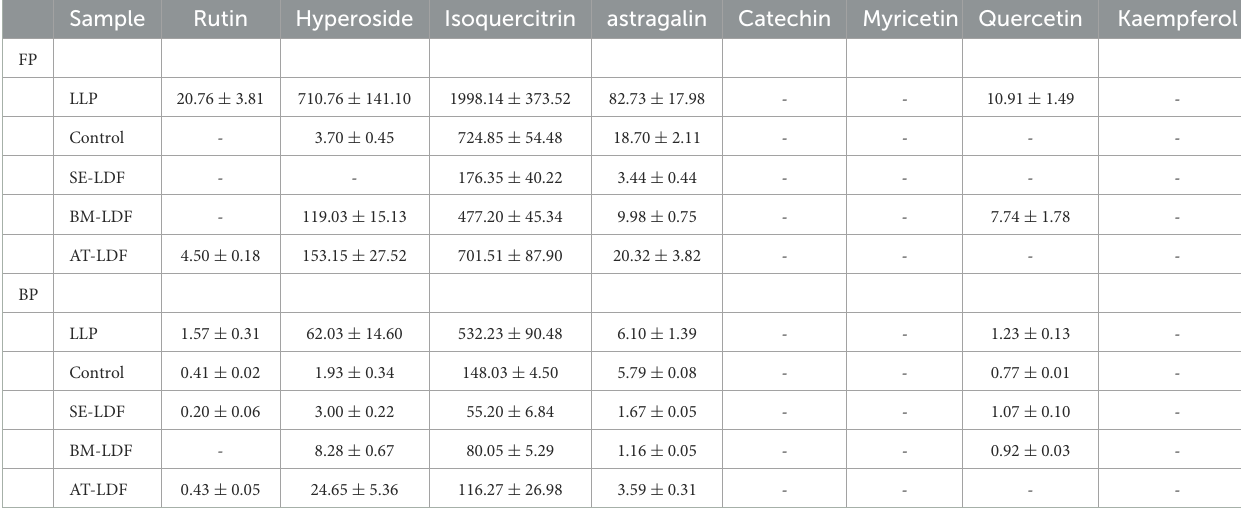
TABLE 2 Flavonoids composition of FP and BP in LLP and LDFs (mg/100g DW). Sample Rutin Hyperoside